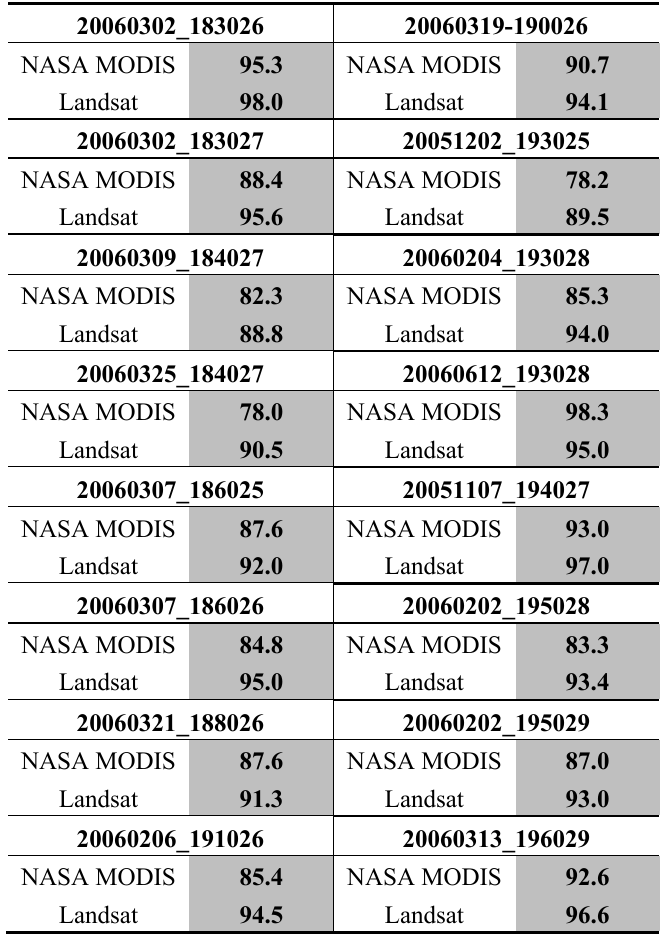
Table 4. Comparison of the overall accuracies (%) of the EURAC snow cover maps (SCA) maps with respect to the Landsat and NASA SCA